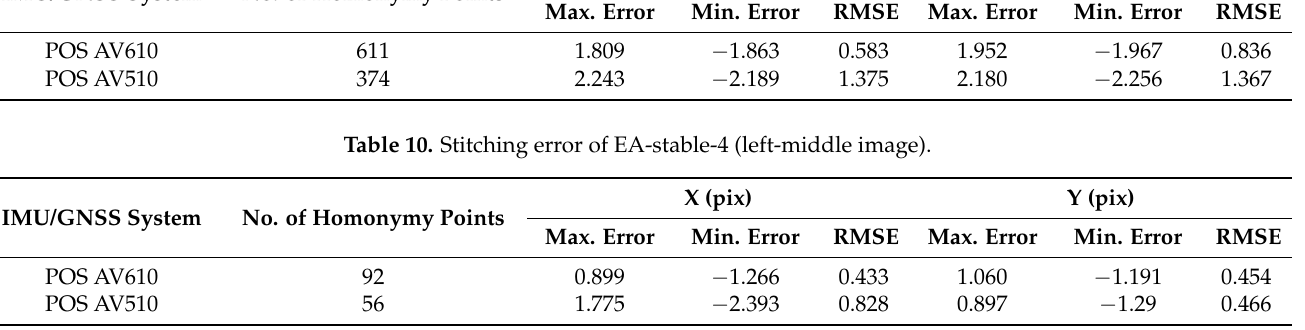
Table 10. Stitching error of EA-stable-4 (left-middle image)